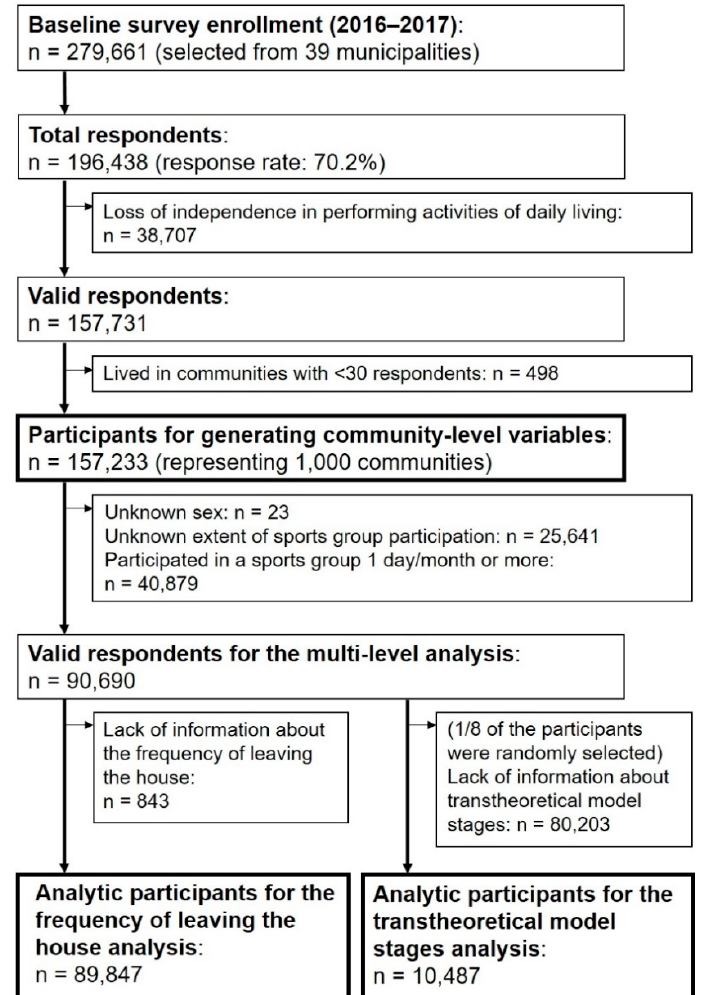
Figure 1. Flow of participants throughout the study. Table 1. Characteristics of the